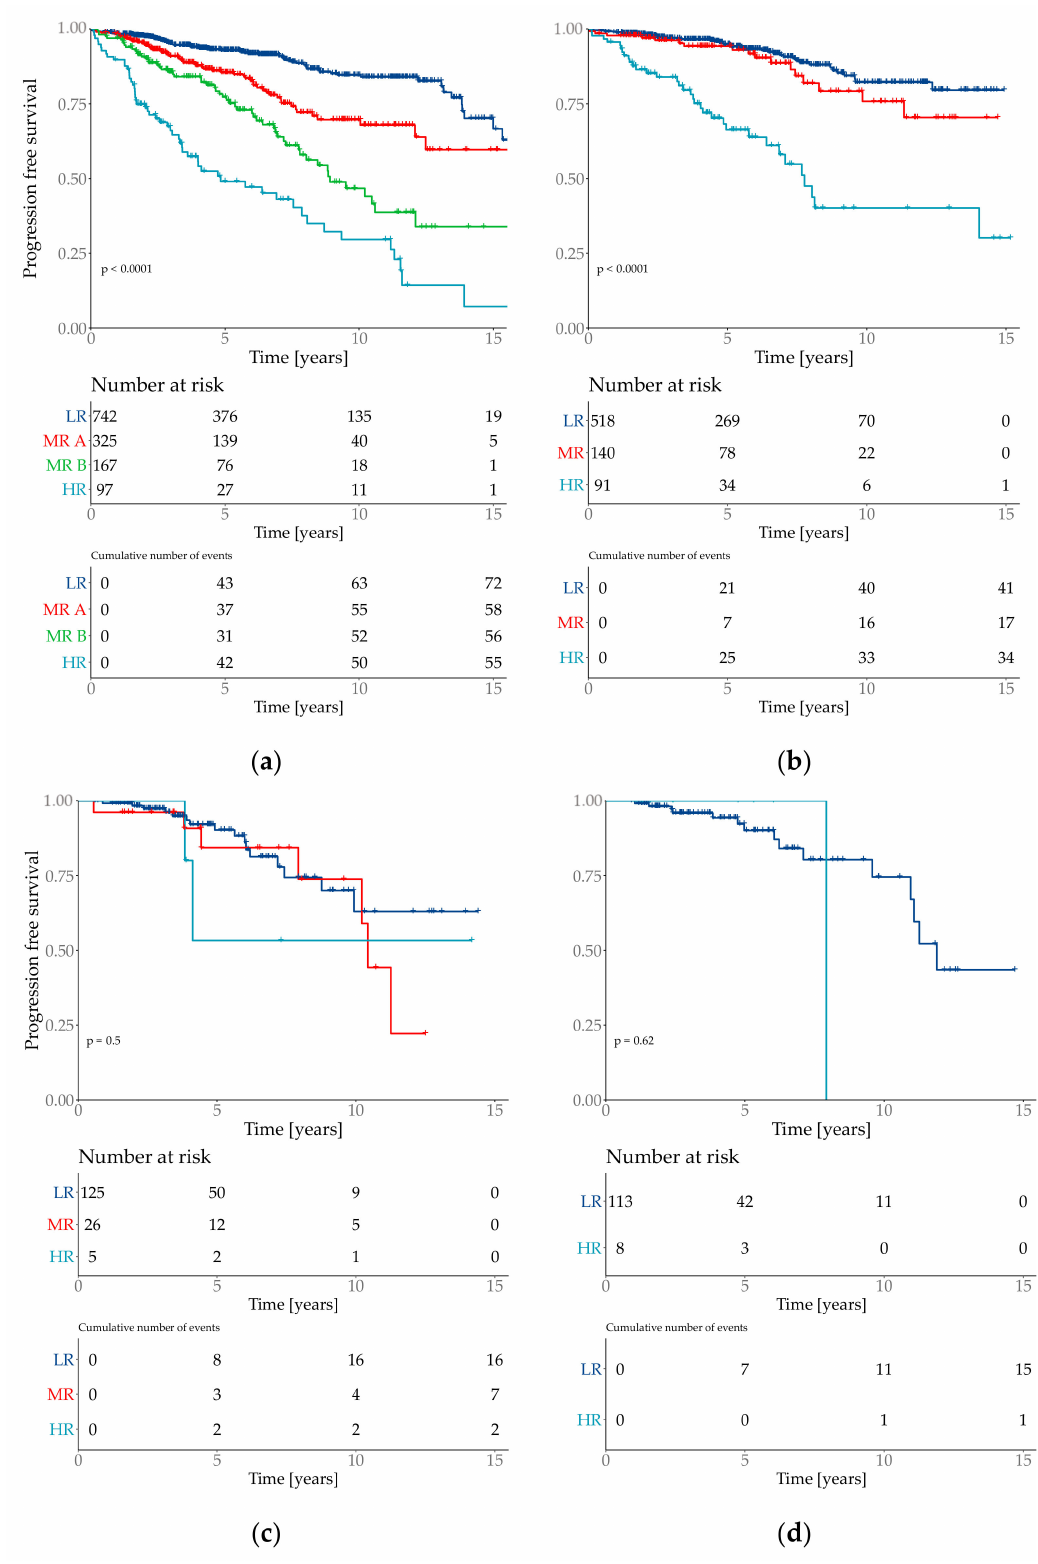
Figure 3. Kaplan–Meier plots of the predicted risk groups. Y -axis is progression free survival. Risk groups are specified as low risk (LR), medium risk (MR) and high risk (HR). Plot ( a ) Total cohort–6654 patients with 2 medium risk groups which are specified as MR A and MR B. ( b ) filtered cohort–3744 patients; ( c ) all special types (=not WHO 8500/3); ( d ) subtype invasive lobular (=WHO